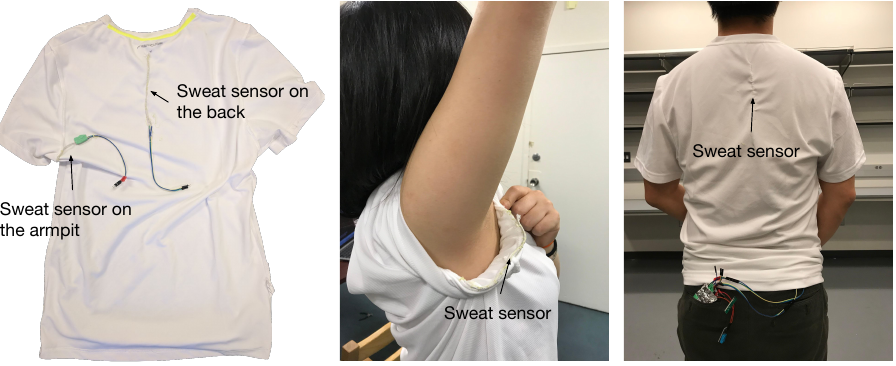
Figure 15. On-body experiment settings and sensor calibration. Two sweat sensors were sewn into a shirt at similar locations to conduct the sensor calibration before beginning the human